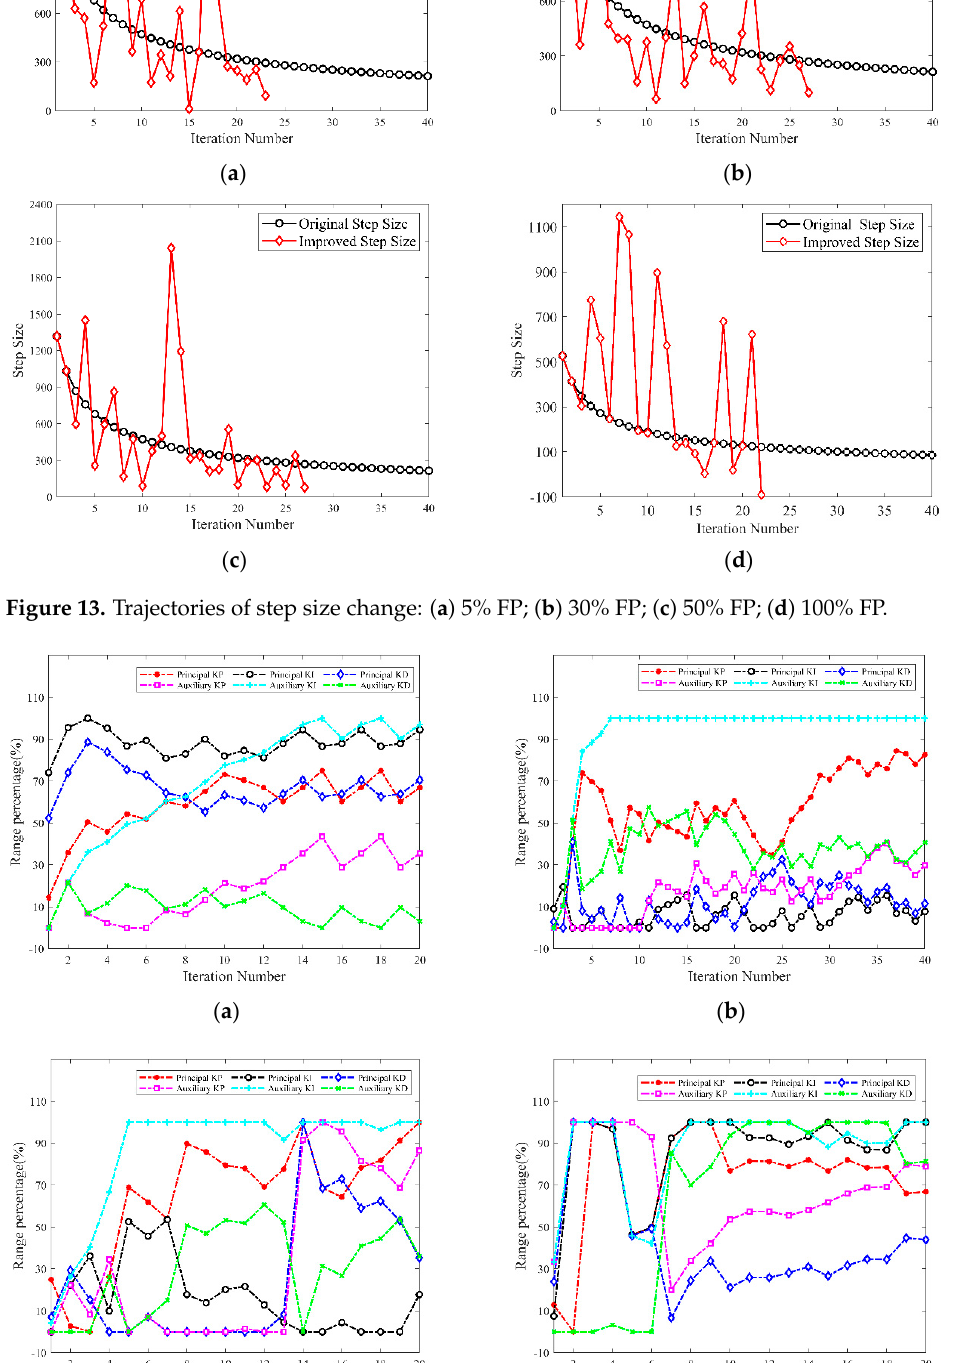
Figure 14. Trajectories of optimizing parameters change: ( a ) 5% FP; ( b ) 30% FP; ( c ) 50% FP; ( d ) 100%